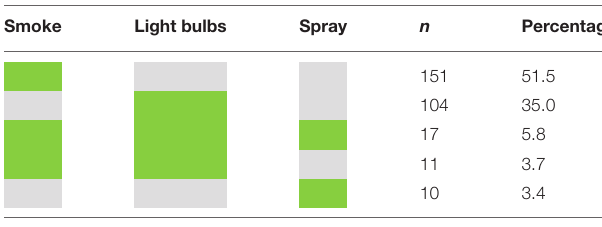
Green and gray colors indicate applicable and not applicable of a particular practice,